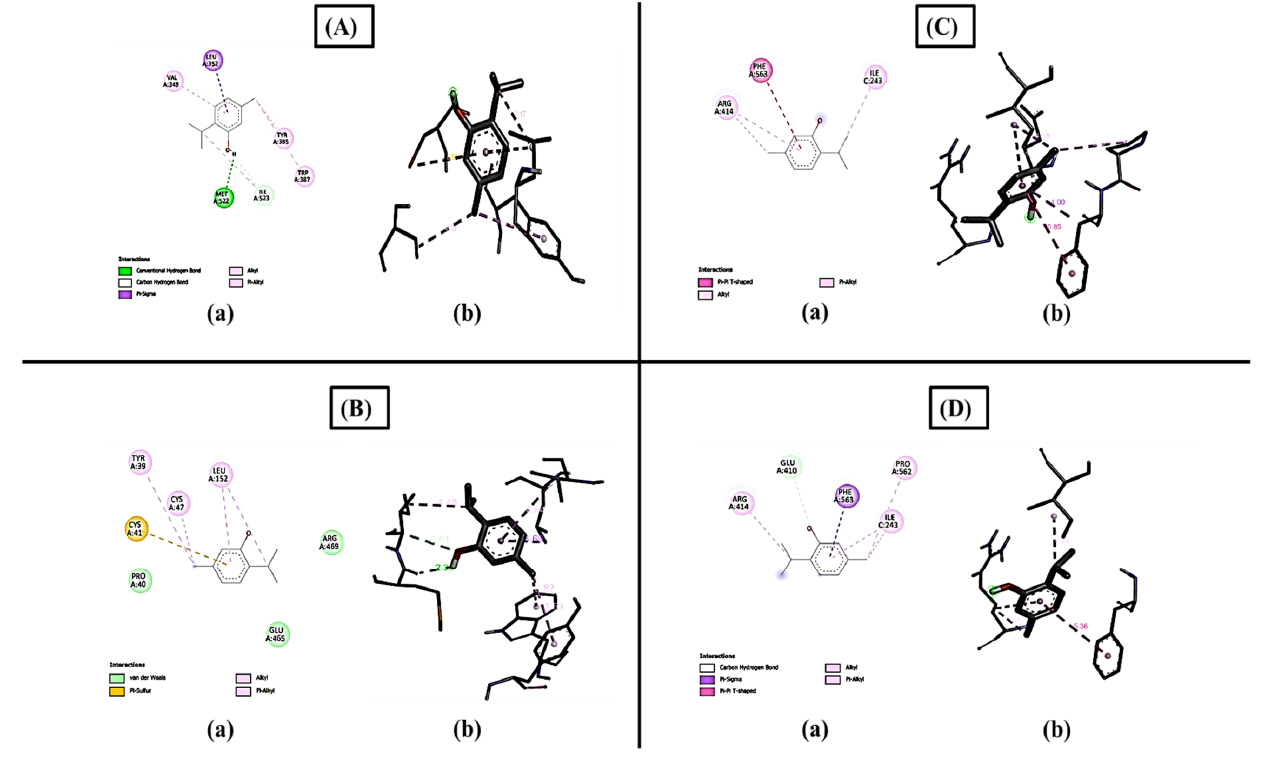
Figure 8. Binding residues of compounds with COX1 and COX2: ( A ) represents the thymol compound docked with COX1 (−6.4), ( a ) shows the 2D image of the compound and ( b ) shows the 3D image of the compound with binding residues, ( B ) represents docked complex of carvacrol with COX1(−6.3): ( a ) shows the 2D image of the docked compound and ( b ) shows the 3D image of the docked compound with binding amino acid residues, ( C ) represents the docked complex of thymol with COX2 (−6.3): ( a ) shows the 2D diagram of the docked compound and ( b ) shows the 3D image of the docked compound with binding amino acids, and ( D ) represents the docked complex of carvacrol with COX2 (−6.2): ( a ) shows the 2D image of the carvacrol docked compound with COX2 and ( b ) shows the 3D image of the docked compound with binding amino acids.